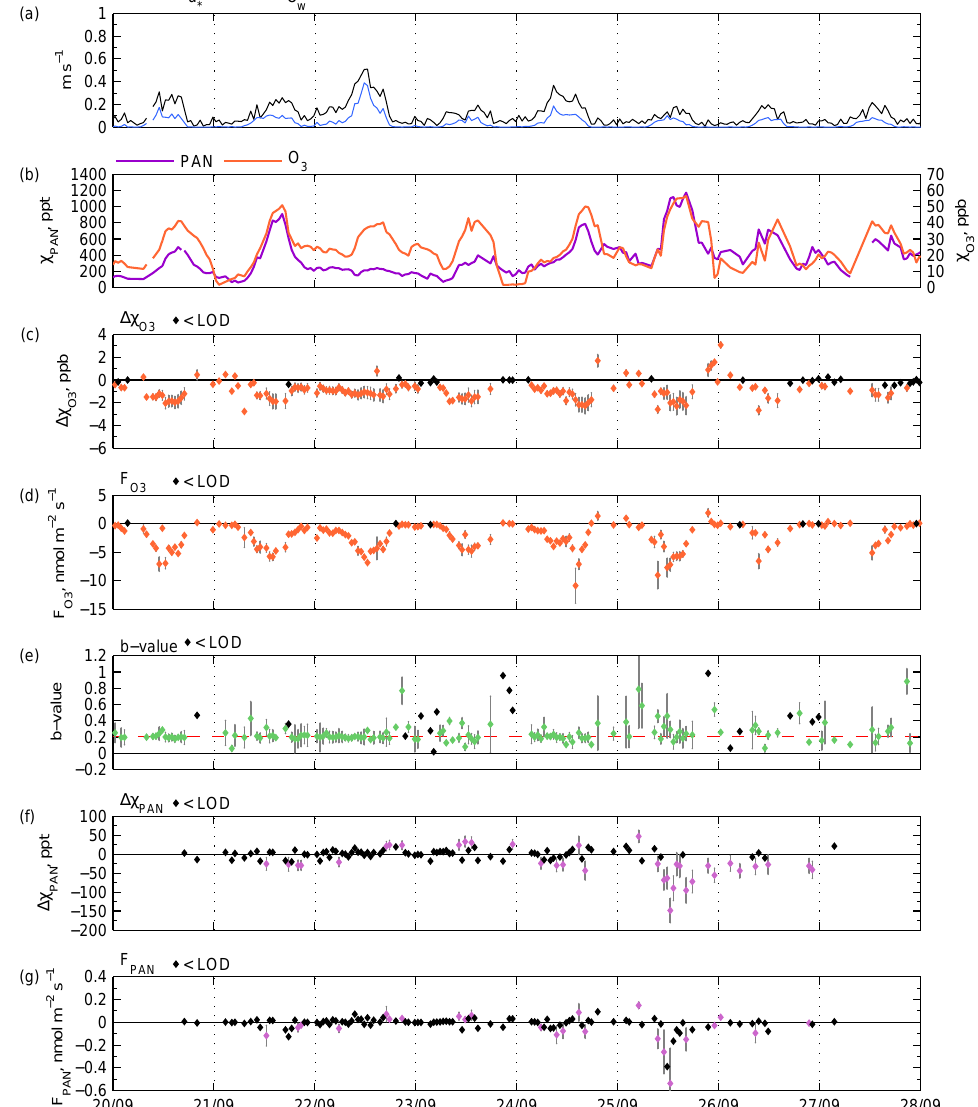
Figure 7. Results from the HREA experiment at the Mainz-Finthen grassland site from 20 to 27 September 2011 showing (a) u ∗ and σ w , (b) PAN and O 3 mixing ratios, (c) 1χ O , (d) F O , (e) b value, (f) 1χ PAN and (g) F PAN . Grey error bars denote random error. Black data 3 3 points indicate values below the detection limit (for details see